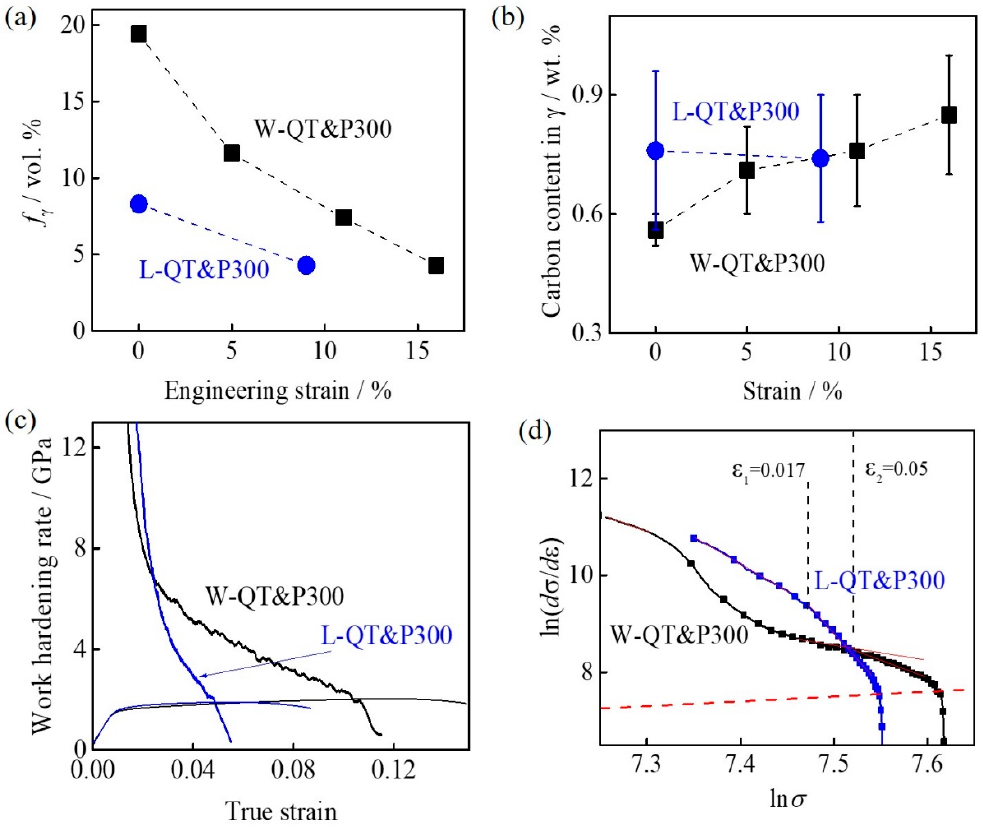
Figure 6. ( a ) The volume fraction of retained austenite and ( b ) average carbon content in γ after different engineering strains in W-QT&P300 and L-QT&P300 steels. ( c ) Variation of work hardening rate ( d σ / d ε ) with true strain. ( d ) ln( d σ / d ε ) vs. ln σ curves of W-QT&P300 and L-QT&P300 with different slopes analyzed by a modified Crussard − Jaoul (C − J) analysis.